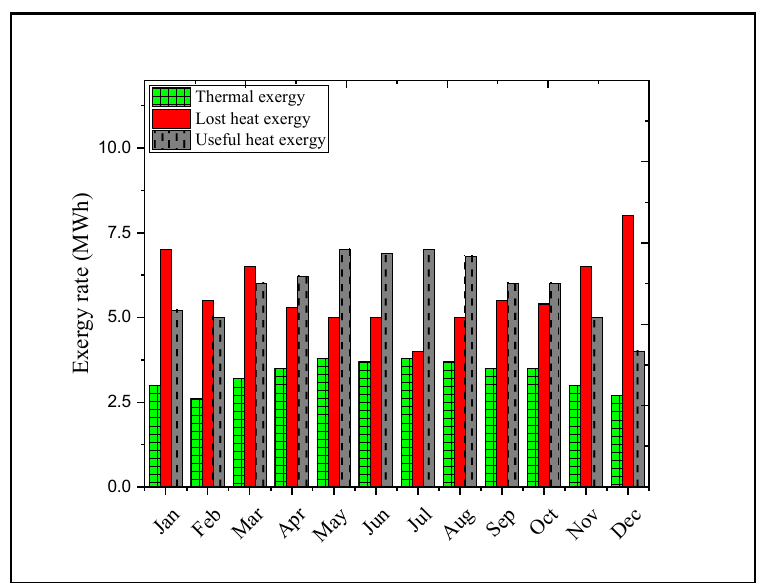
Figure 7. Thermal exergy, lost heat exergy and monthly useful heat exergy in Kerman city.